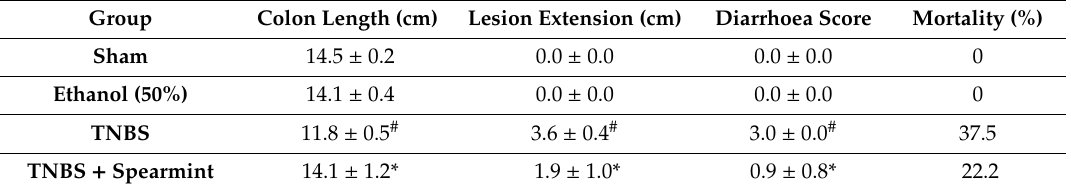
Table 3. E ff ect of spearmint treatment in the evaluated macroscopic markers of TNBS-induced colitis. Group Colon Length (cm) Lesion Extension (cm) Diarrhoea Score Mortality (%) Sham 14.5 ± 0.2